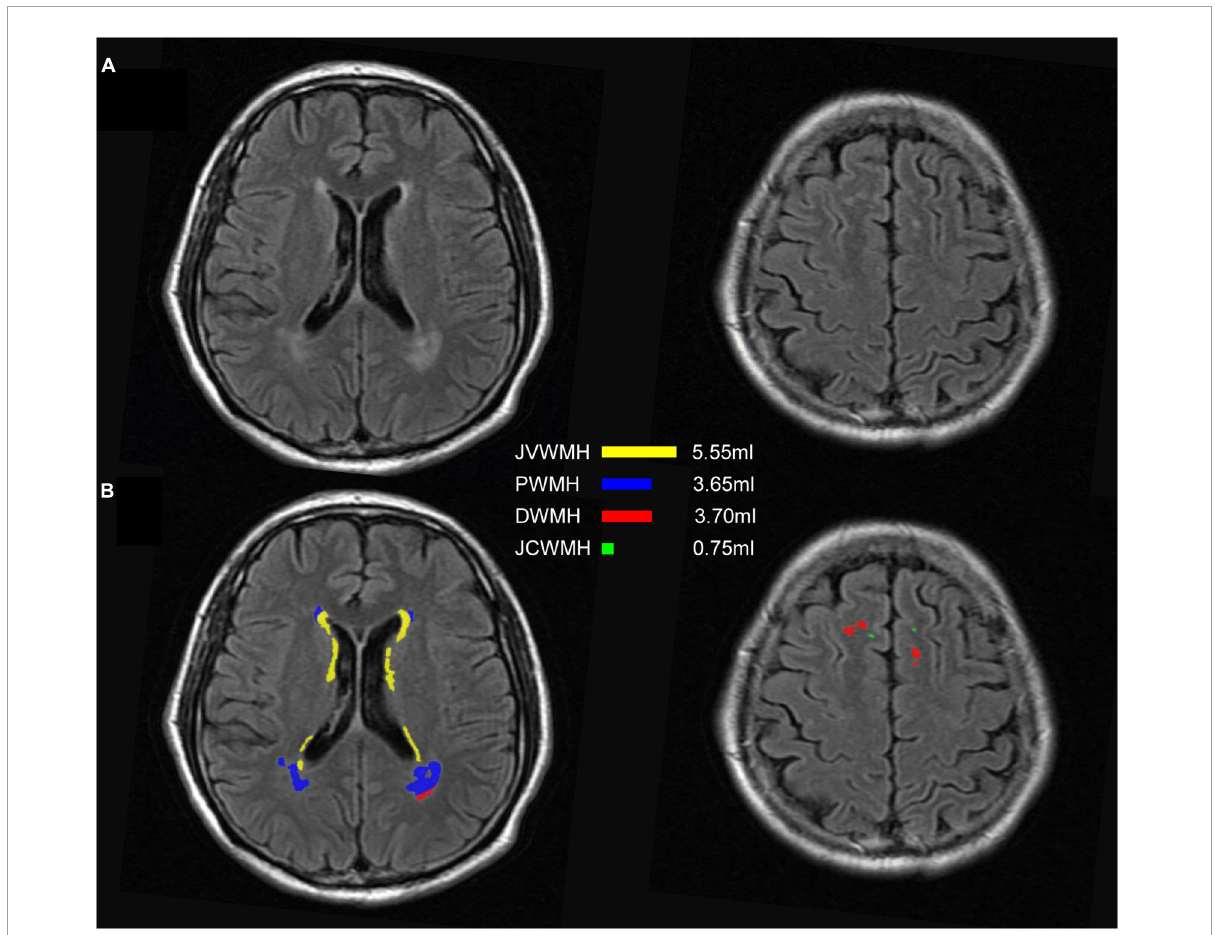
FIGURE6 An example of segmentation results for subclassified WMH according to Kim’s criteria. (A) FLAIR images; (B) display of the segmentation map and the volumes of each subclassified WMH area according to Kim’s criteria. The regions of each subclassified WMH are represented by different colors. DWMH, deep white matter hyperintensities; JVWMH, juxtaventricular white matter hyperintensities; JCWMH, juxtacortical white matter hyperintensities; and PWMH, periventricular white matter hyperintensities.